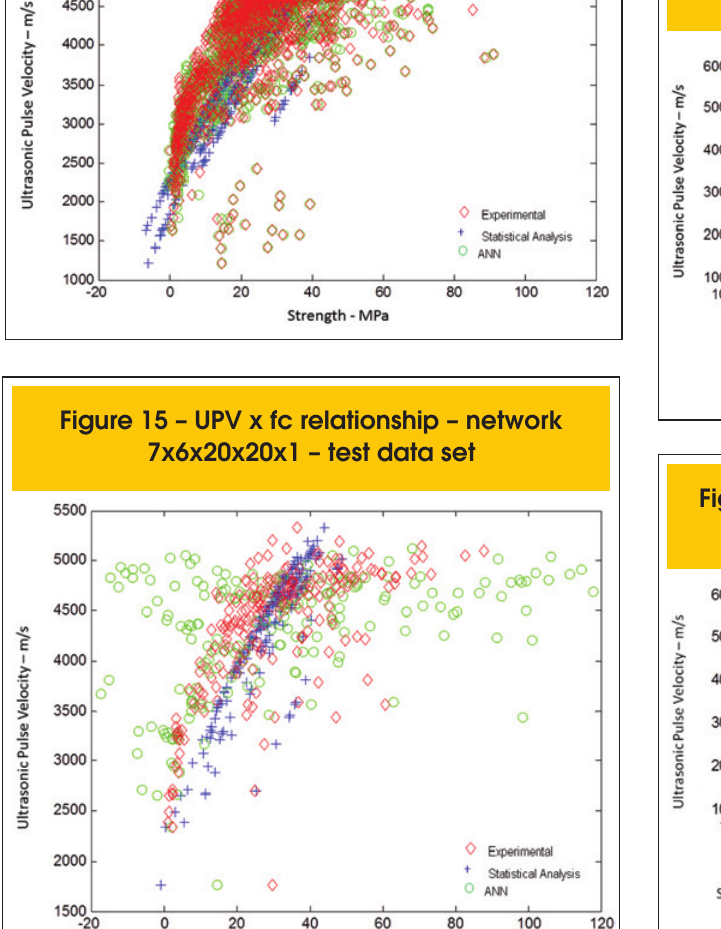
Figure 17 – UPV x fc x age relationship – network 7x6x20x20x1 – test data set